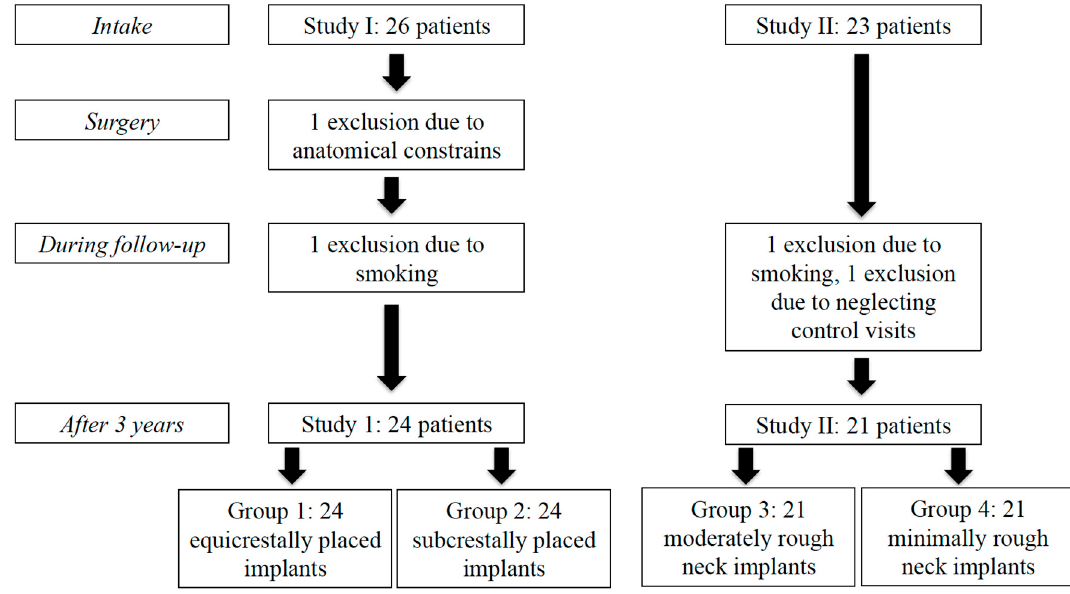
Figure 2. Flowchart of both study populations.